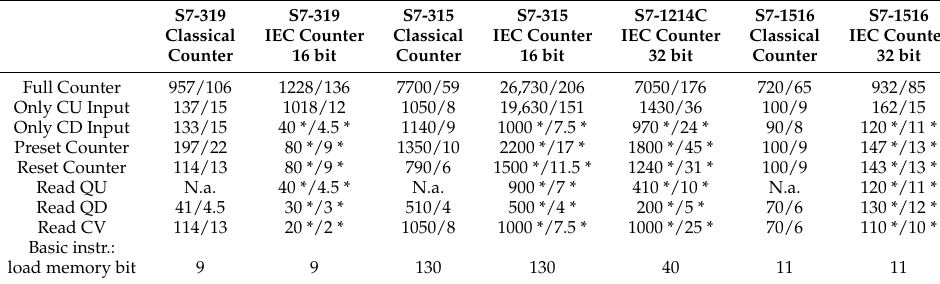
Table 4. Comparison times of counters operators’ execution times for Simatic Controllers.